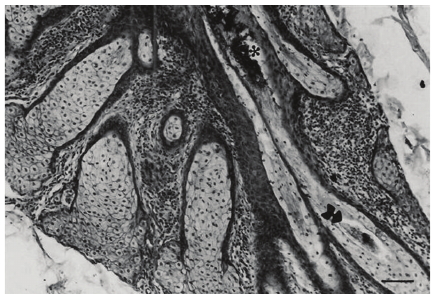
Figure 7: Sections from the eyelid of a cow, showing invasion of the meibomian gland with Demodex ghanensis . Note hemorrhage, exudation, and damage of the proximal part of the main collecting tubule (asterisks), marked infiltration with inflammatory cells, dilatation of the main collecting tubules, and Demodex ghanensis mite in the main collecting tubule (black arrow). Haematoxylin and Eosin. Scale bar: 120 𝜇 m.